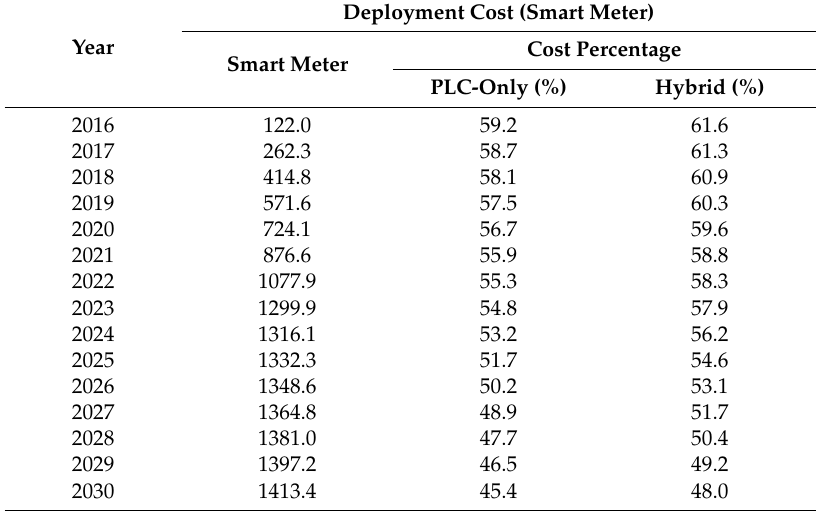
Table 3. Comparison Results of Total Deployment Cost and Smart Meter Cost (Billion KRW).